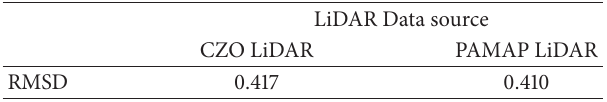
Table 1: RMSD for PAMAP LiDAR and CZO LiDAR in the Leading Ridge Watershed (in meters).